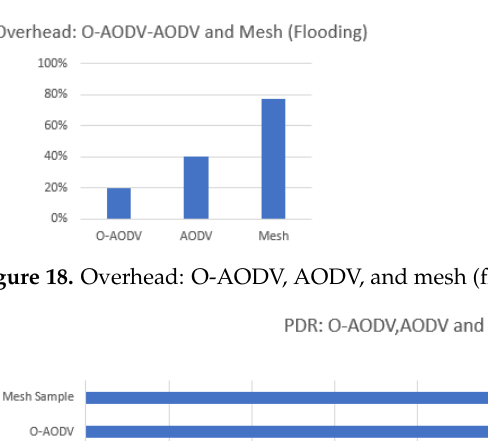
Figure 17. Average end-to-end delay: O-AODV, AODV, and mesh (flooding) comparison.